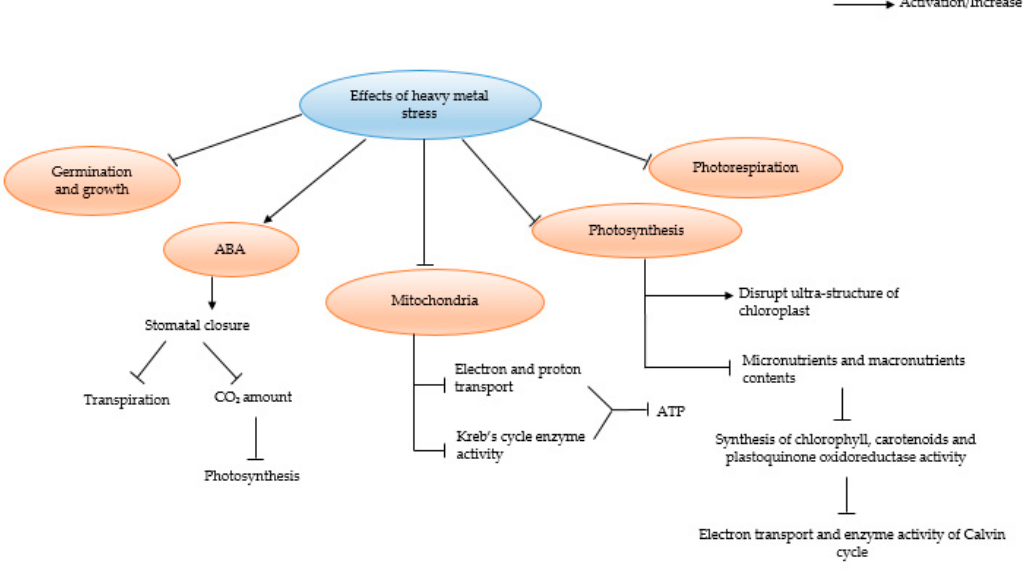
Figure 3. E ff ects of heavy metals on plants Figure 3. Effects of heavy metals on plants [117,100].